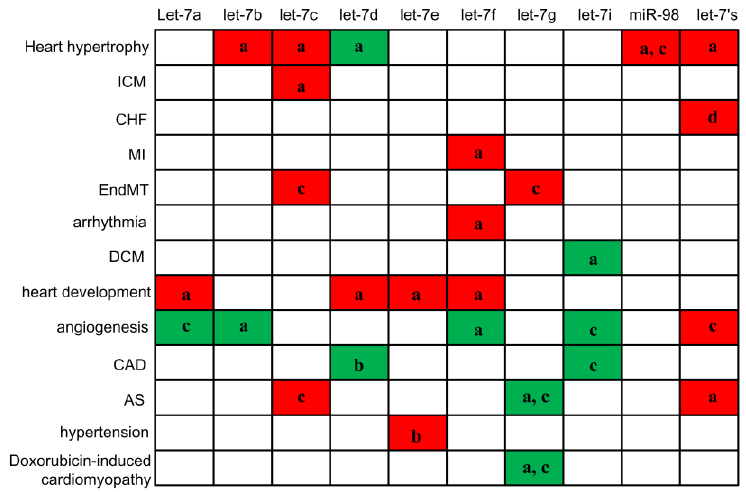
Figure 5. Modulation of let-7 in different cardiovascular diseases. Red color indicates let-7s that are significantly up-regulated, green color indicates let-7s that are significantly down-regulated.